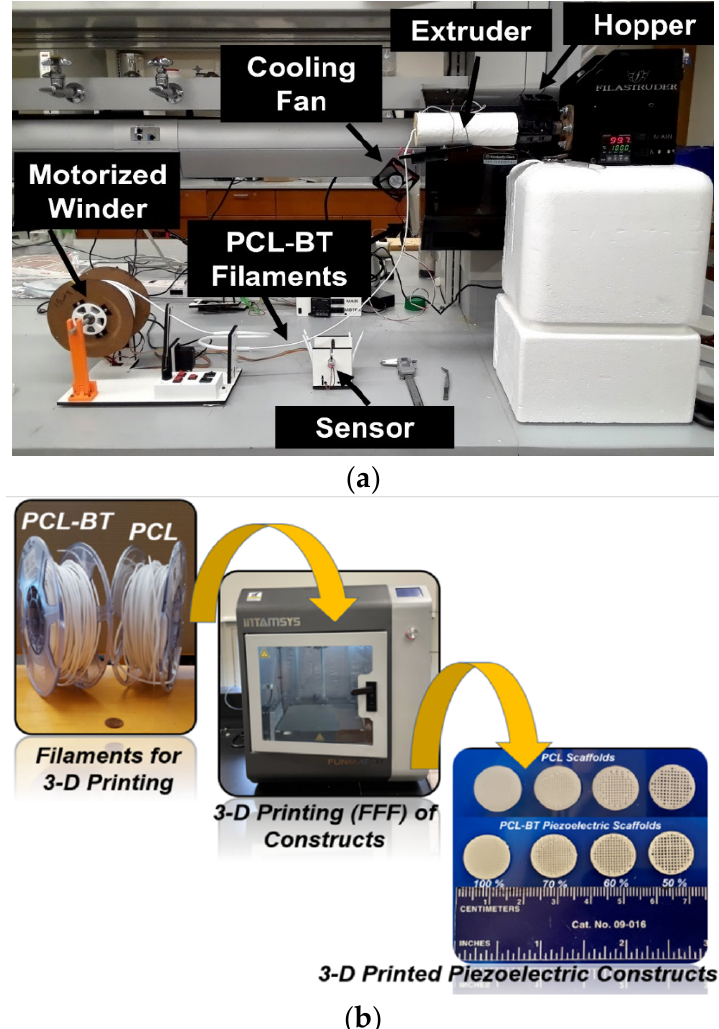
Figure 2. Setup for filament extrusion and 3D printing. ( a ) The assembled Filastruder extruder and filament winder setup that was used to extrude the 3D-printable filaments. ( b ) The workflow shows that the filaments were used in a 3D printer setup to develop the piezoelectric PCL- BT composite scaffolds.